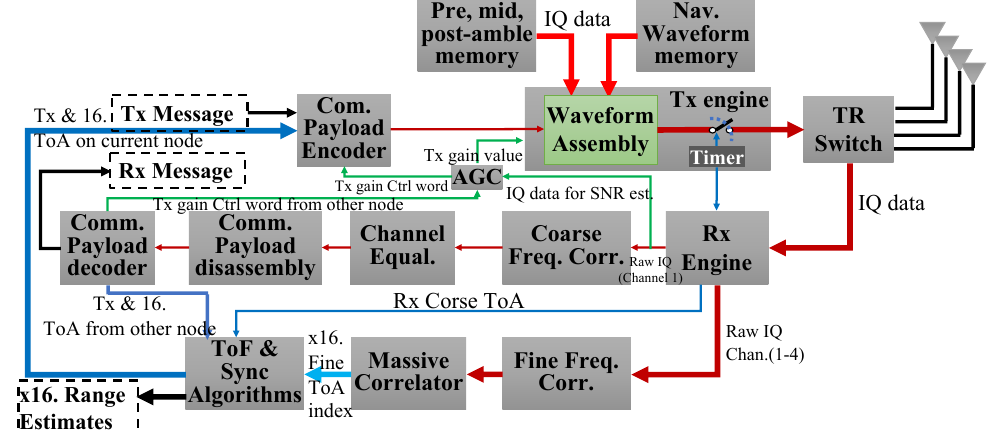
Figure 12. CHP2 processing chain block diagram.